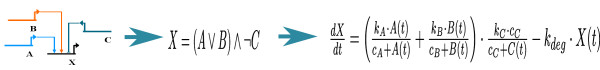
Construction of ODEs from network topology. Schematic representation of the conversion of a GRN topology to an ODE model. In the diagram to the left, A, B, C and X denote genes. In the Boolean formula in the center, the variables represent the gene products, translation and transcription are combined to one step. In the differential equation to the right, X indicates concentration of mRNA of gene X, while A, B and C are protein concentrations, small letters are kinetic parameters. The topology is used to derive a Boolean formulation of the regulatory inputs to a gene. This Boolean formulation is automatically translated to an ODE model. For details, see section Methods.